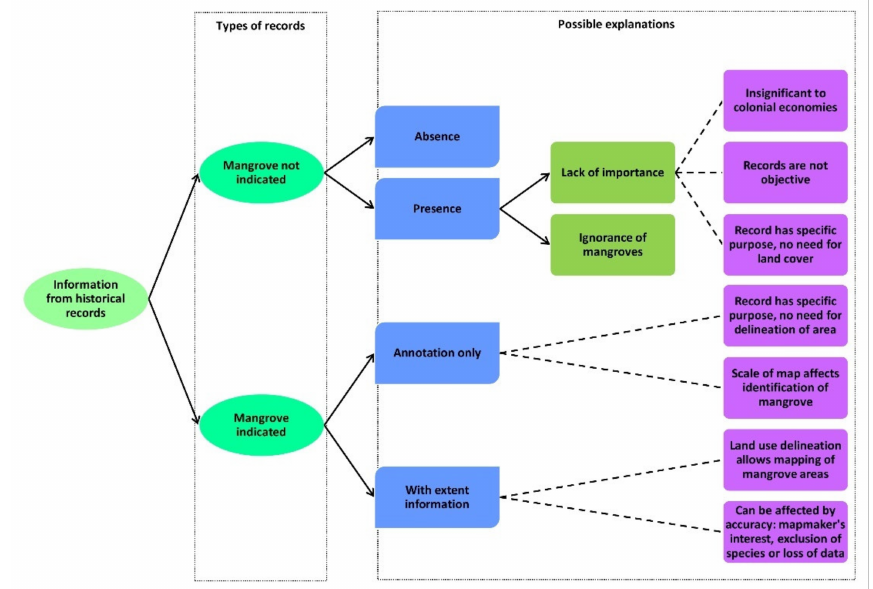
Figure 8. Summary of the different types of historical records obtained and the possible explanations for the inclusion/exclusion of information on mangrove system in Peninsular